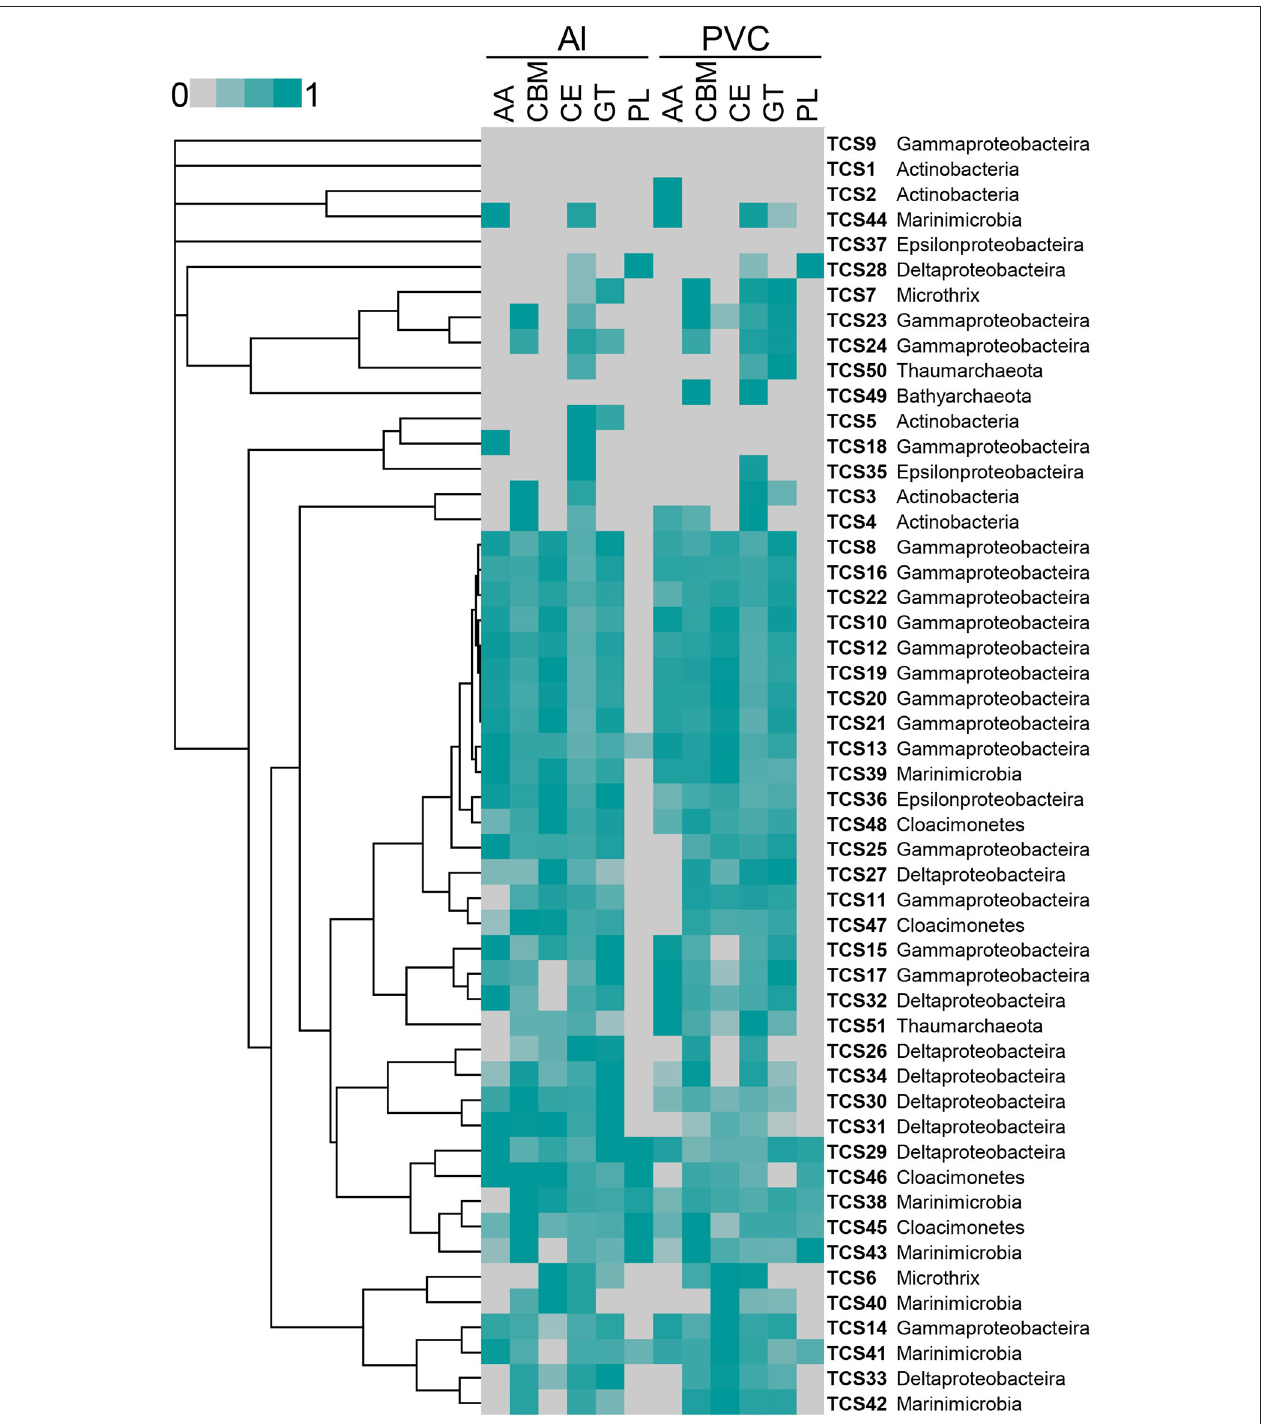
FIGURE 4 | Relative abundance of expressed genes for carbohydrate metabolism from each MAG. Expression levels for auxiliary activities (AAs), carbohydrate-binding module (CBMs), carbohydrate esterases (CEs), glycoside hydrolases (GHs), Glycosyltransferase (GTs), and polysaccharide lyases (PLs) from each MAG in the biofilm_Al and biofilm_PVC metatranscriptomes are shown. Gene expression abundance is the number of transcripts mapped to the CAZys of each MAG that normalized to the length of the genes. The highest expression level was normalized as “1.”